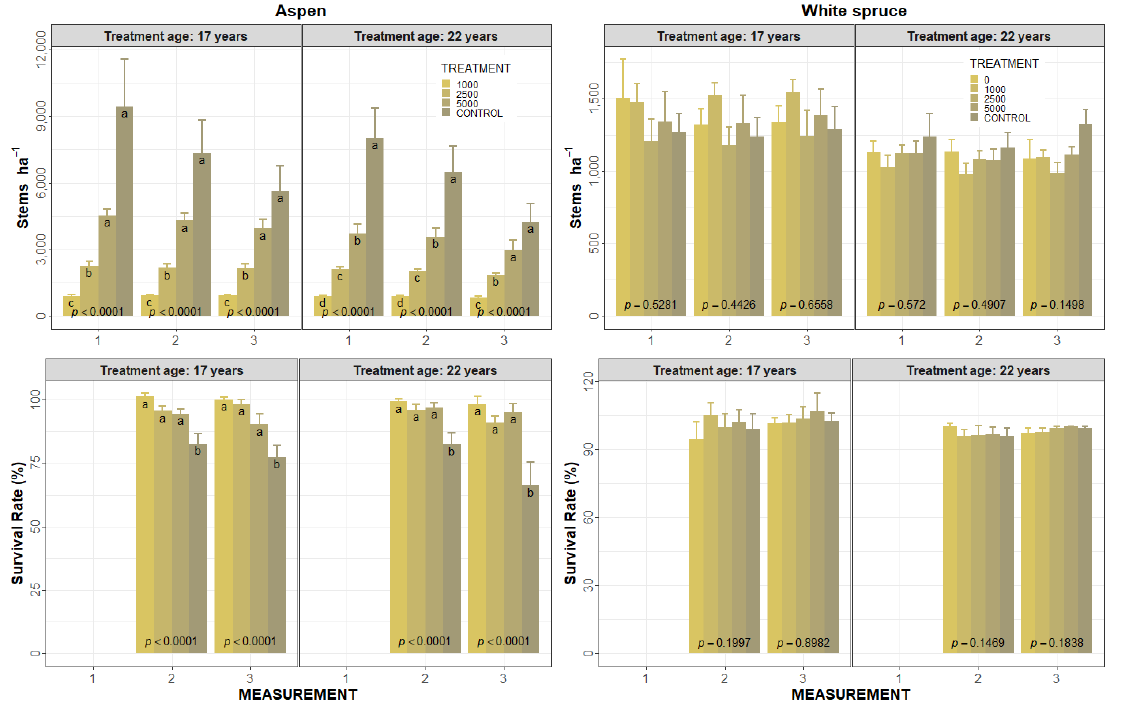
Figure 3. Density (stems ha − 1 ) and survival rate (%) for aspen and spruce by treatment age group, measurement and treatment target density. Bars represent the treatment mean plus one standard error of the mean; numbers are the p -values from mixed-model Analysis of Variance (ANOVA) for a treatment difference; groups of bars within treatment age and measurement years with different letters indicate significant differences between treatments based on Tukey’s post-hoc test with Bonferroni’s adjustment. Survival rates for measurement periods two and three were calculated over a three- and five-year period